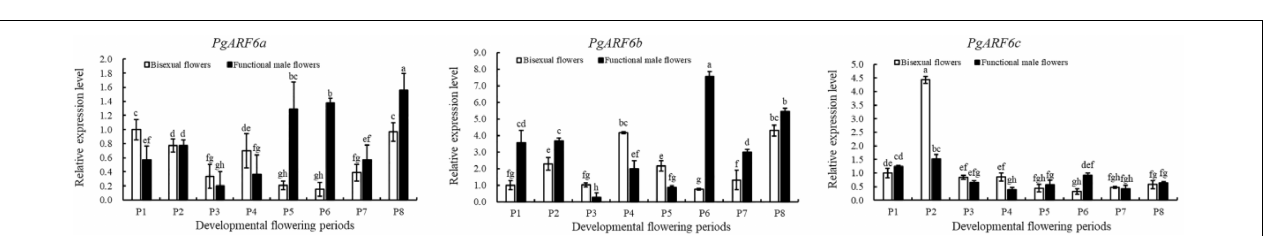
FIGURE 7 | Transcriptome and small-RNA sequencing results of PgARF6 -PgmiR167 expression analysis.